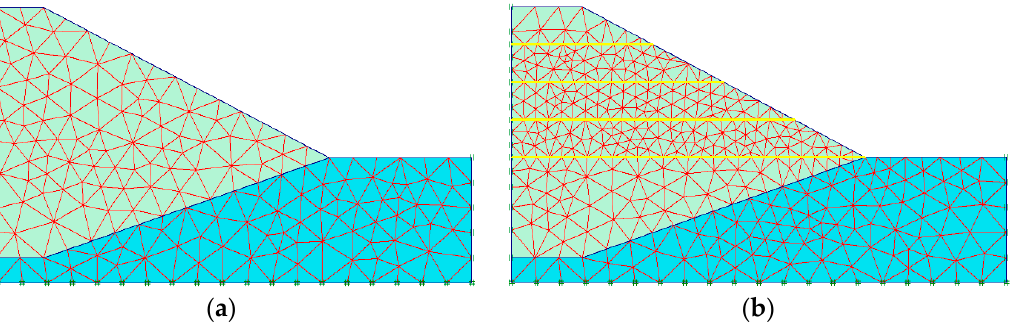
Figure 2. ( a ) Unreinforced; ( b ) reinforced. Slope geometry used in finite element analyses.